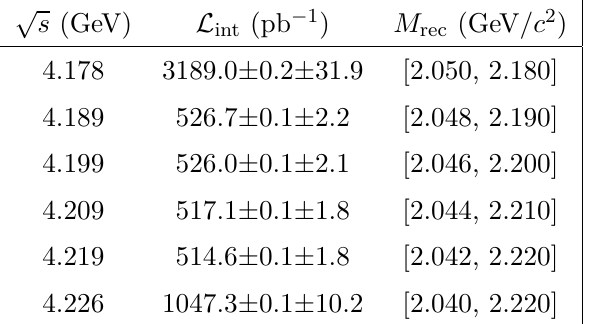
Table 1 . The integrated luminosities ( L int ) and the requirements on M rec for various collision energies. The definition of M rec is given in eq. (3.1). The first and the second uncertainties are statistical and systematic,